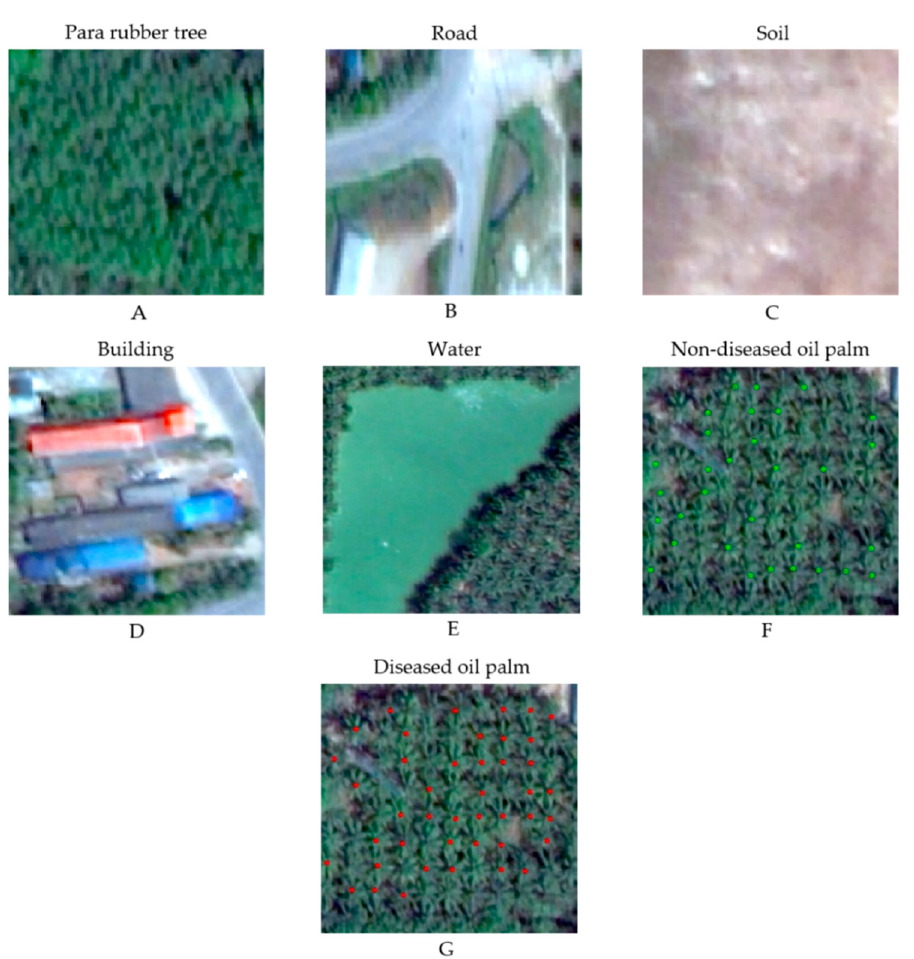
Figure 3. Samples of the 7 classes selected for the supervised classification scheme; ( A ) Para rubber tree, ( B ) Road, ( C ) Soil, ( D ) Building, ( E ) Water, ( F ) Non-diseased oil palm, ( G ) Diseased oil palm.